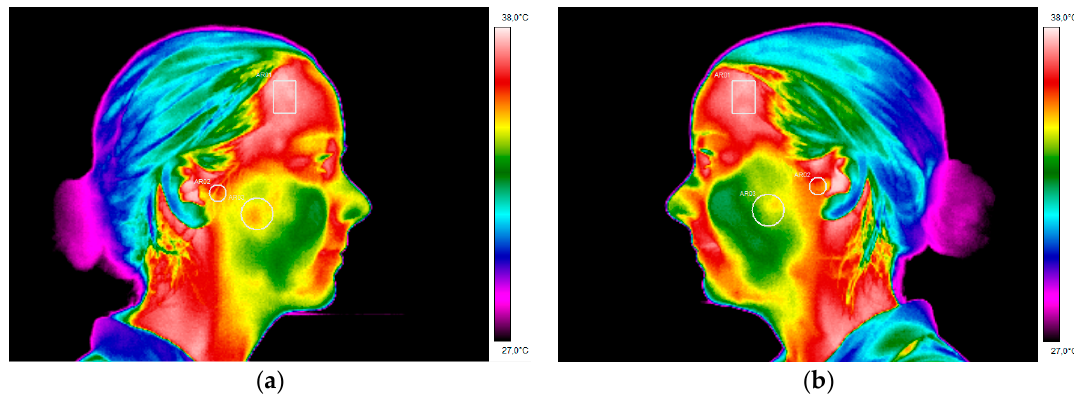
Figure 9. Right and left side infrared images of the clarinettist at the first appointment. ( a ) Right side thermogram, AR01—Region of interest corresponding to the temporal muscle, AR02—Region of interest corresponding to the TMJ, AR03—Region of interest corresponding to the masseter muscle; ( b ) Left side thermogram with the corresponding contralateral regions of interest being possible to observe the significant temperature differences in AR02.